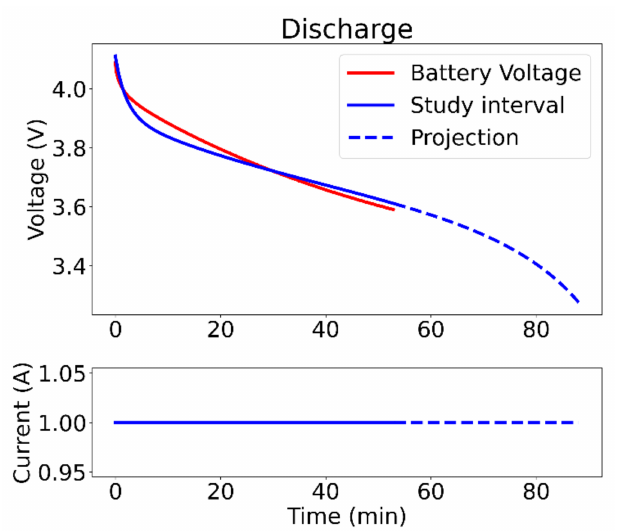
Figure 4. Voltage